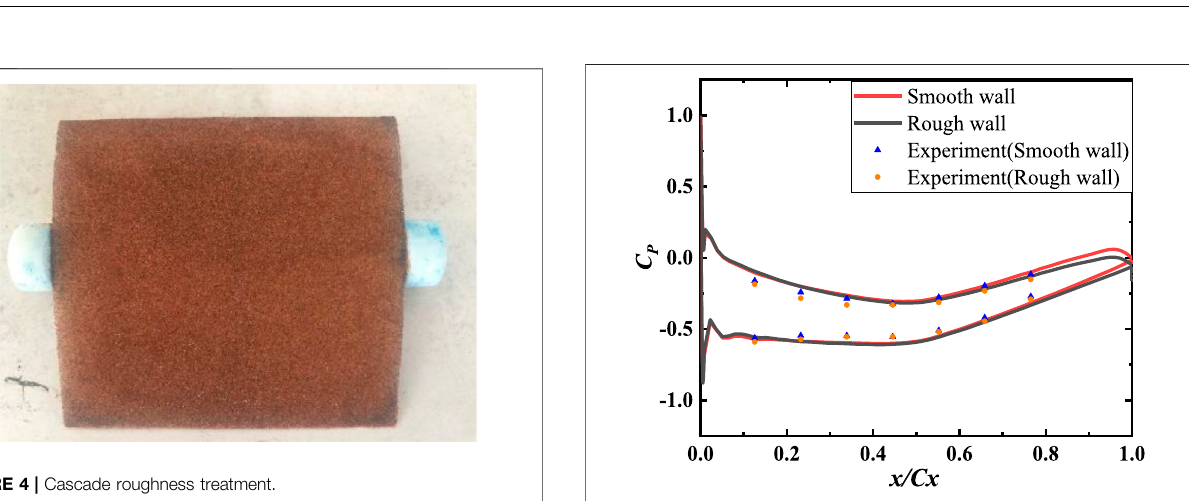
FIGURE 3 | Experimental test pattern: (A) test schematic diagram, (B) test section, and (C) cascade structure and pressure measuring points.